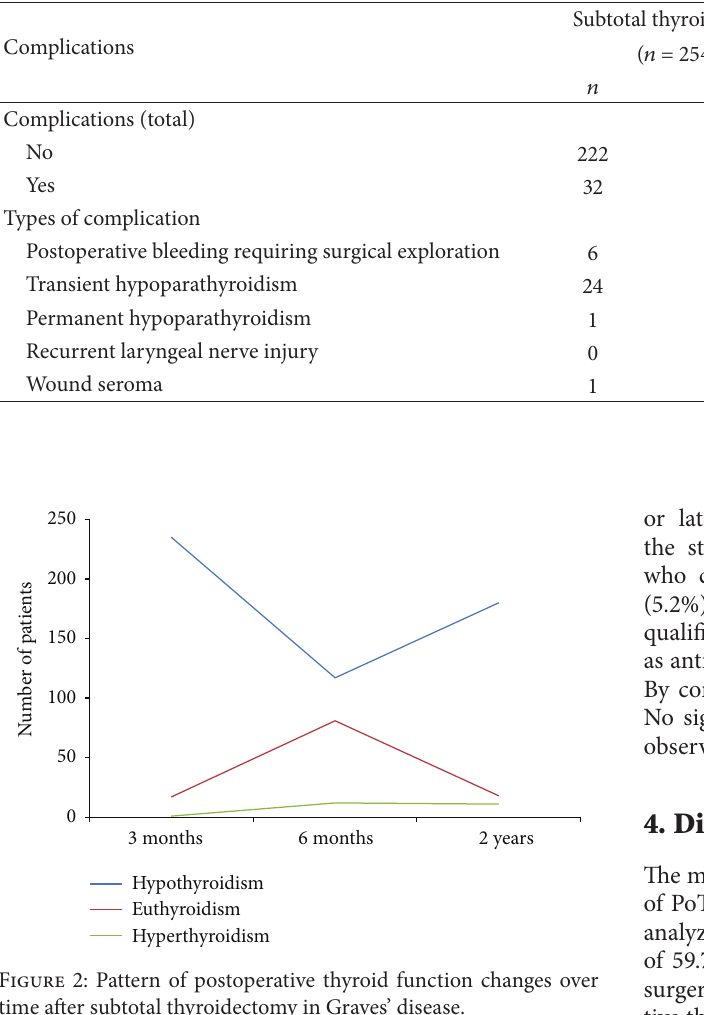
Table 4: Comparison of surgical complication rates between subtotal thyroidectomy and total thyroidectomy in Graves’ disease.